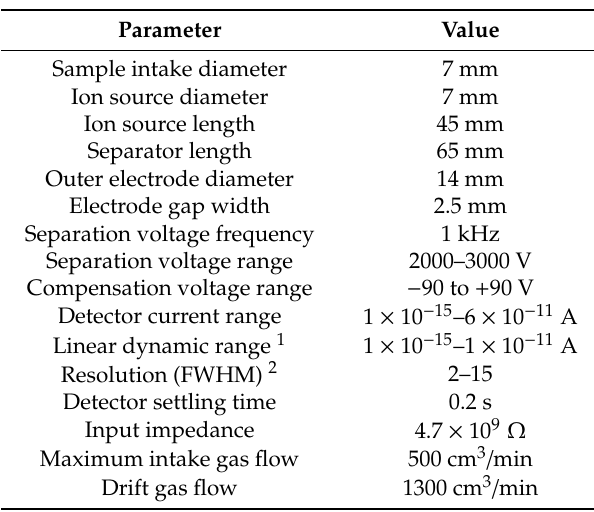
Table 1. Technical parameters of